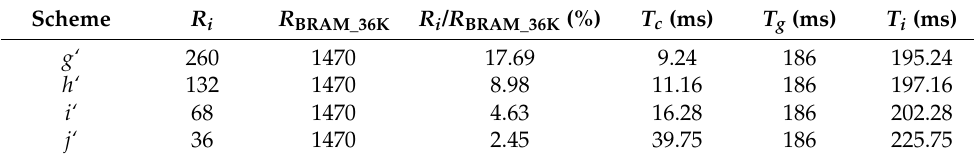
Table 10. Test results of matrix transposition schemes under the condition of c‘ and e‘